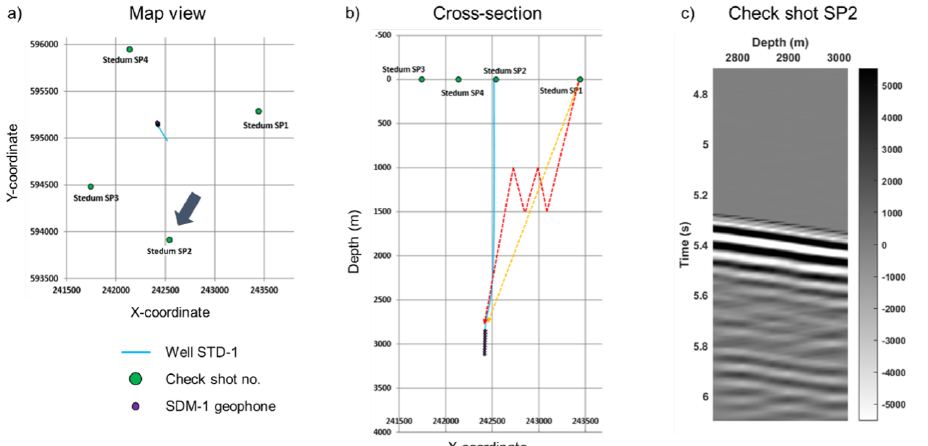
Figure 18. Four check shot locations around the SDM-1 well. ( a ) Map view of check shot locations. SP2 is the furthest check shot from the well (black arrow). ( b ) The cross-section of the map view at the Y-coordinate of the well location. Ray path with more scattering (red-dashed line) arrives at the geophone array with a smaller incident angle than the direct ray path from the source (yellow-dashed line). ( c ) SP2 check shot raw record that is used for time-varying interferometry. Only the 4.7–6.1-s record is shown from the full 30-s